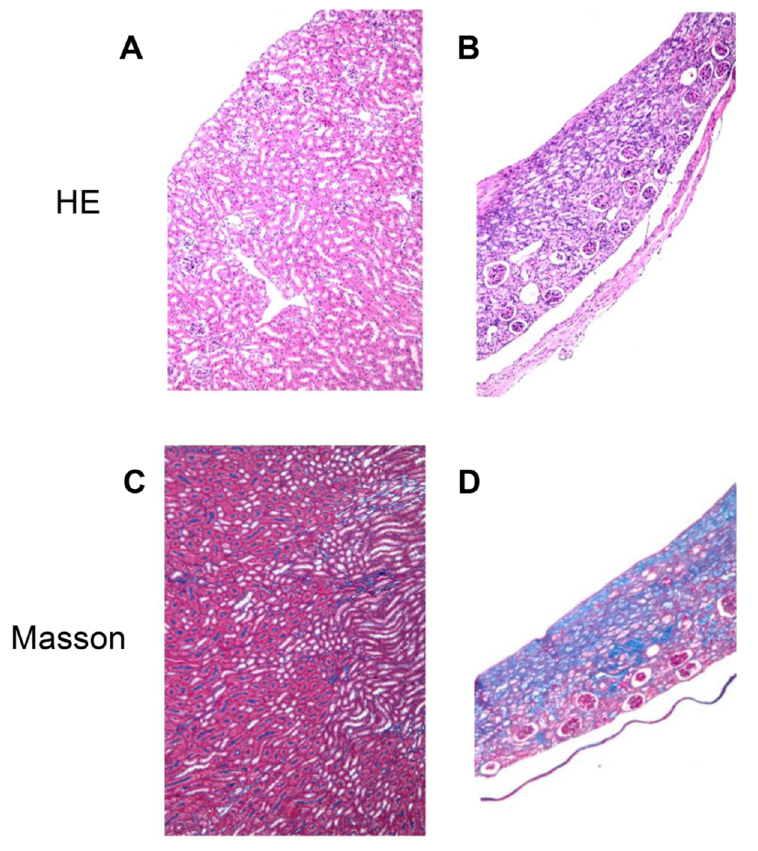
Figure 2. Renal pathological finding in mice underwent sham surgery and unilateral ureteral obstruction (UUO). ( A ) No obvious damage could be found in normal kidney slice. ( B ) Glomerulosclerosis, tubular atrophy, parenchymal loss, and inflammatory cells infiltration were significant in H&E staining of renal fibrosis section. ( C , D ) Masson’s staining indicated small amount collagen deposition (blue staining) in normal kidney section, as well as strong tubulointerstitial collagen staining in renal fibrosis mice.